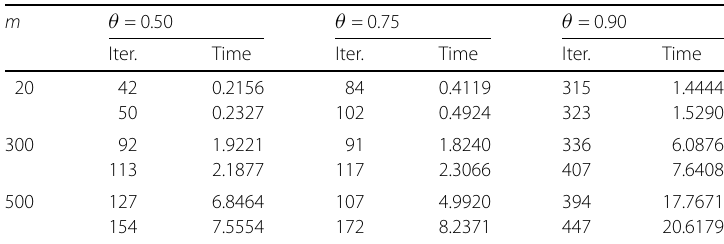
Table 1 Performance of algorithm 3.1 for the number of iterations (Iter.) and the computing time (Time) measured in seconds with m =